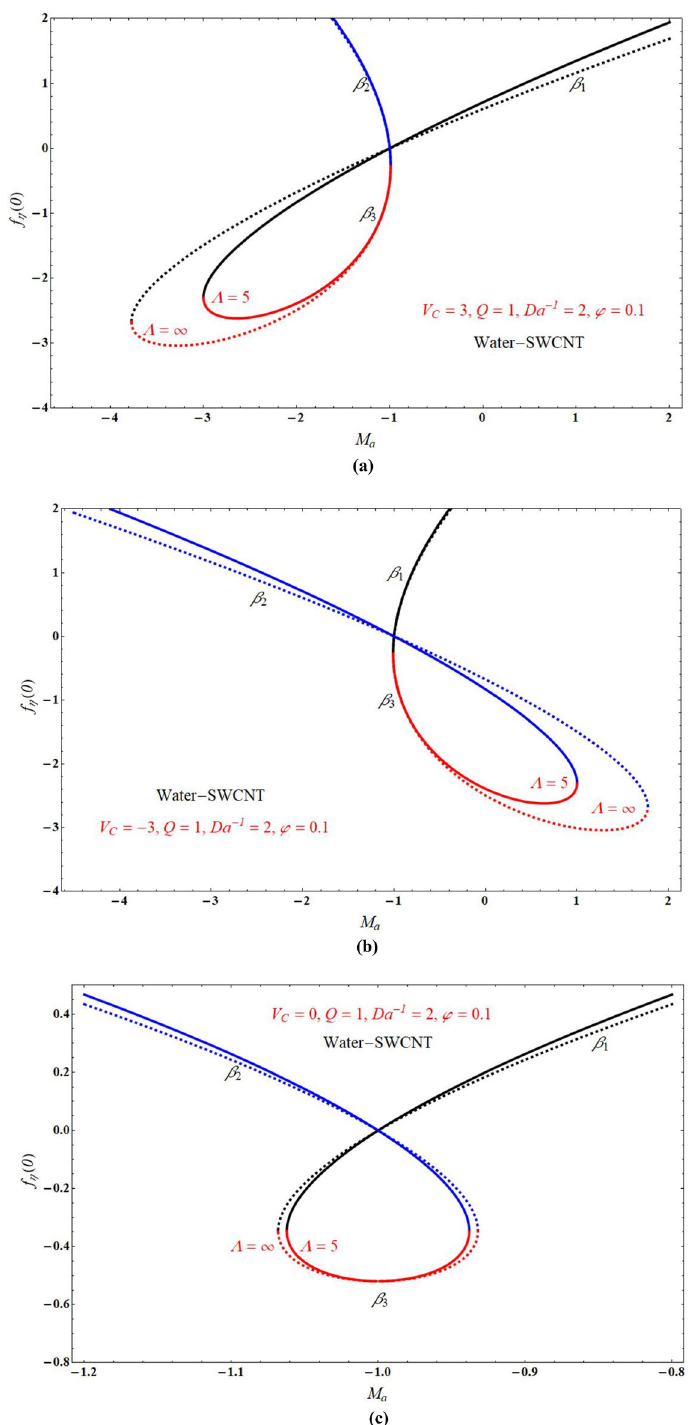
Figure 5. The plots of f η ( 0 ) verses Ma for (cid:31) = 5 and (cid:31) = ∞ at ( a ) V C = 3 , ( b ) V C = − 3 and ( c ) V C = 0